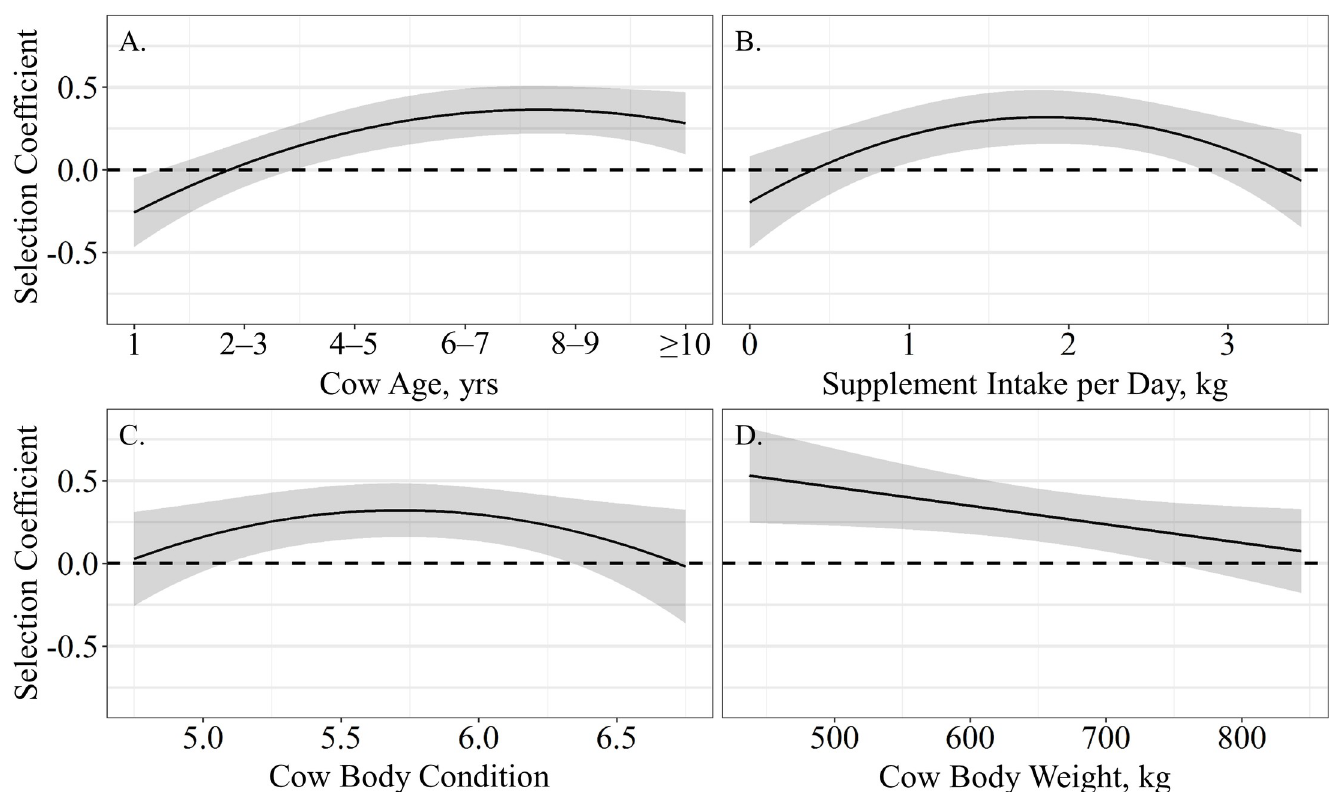
Fig 6. Predicted relationships ( ± 95%CI represented in the shaded area) between ( A ) cow age (years), ( B ) average supplement intake per day (kg), ( C ) cow body condition and ( D ) body weight (kg) on resource utilization relative to elevation by cattle grazing dormant northern mixed grass rangeland in 2016 – 2017 & 2017 – 2018 at the Northern Agricultural Research Center Thackeray ranch, Havre, MT.